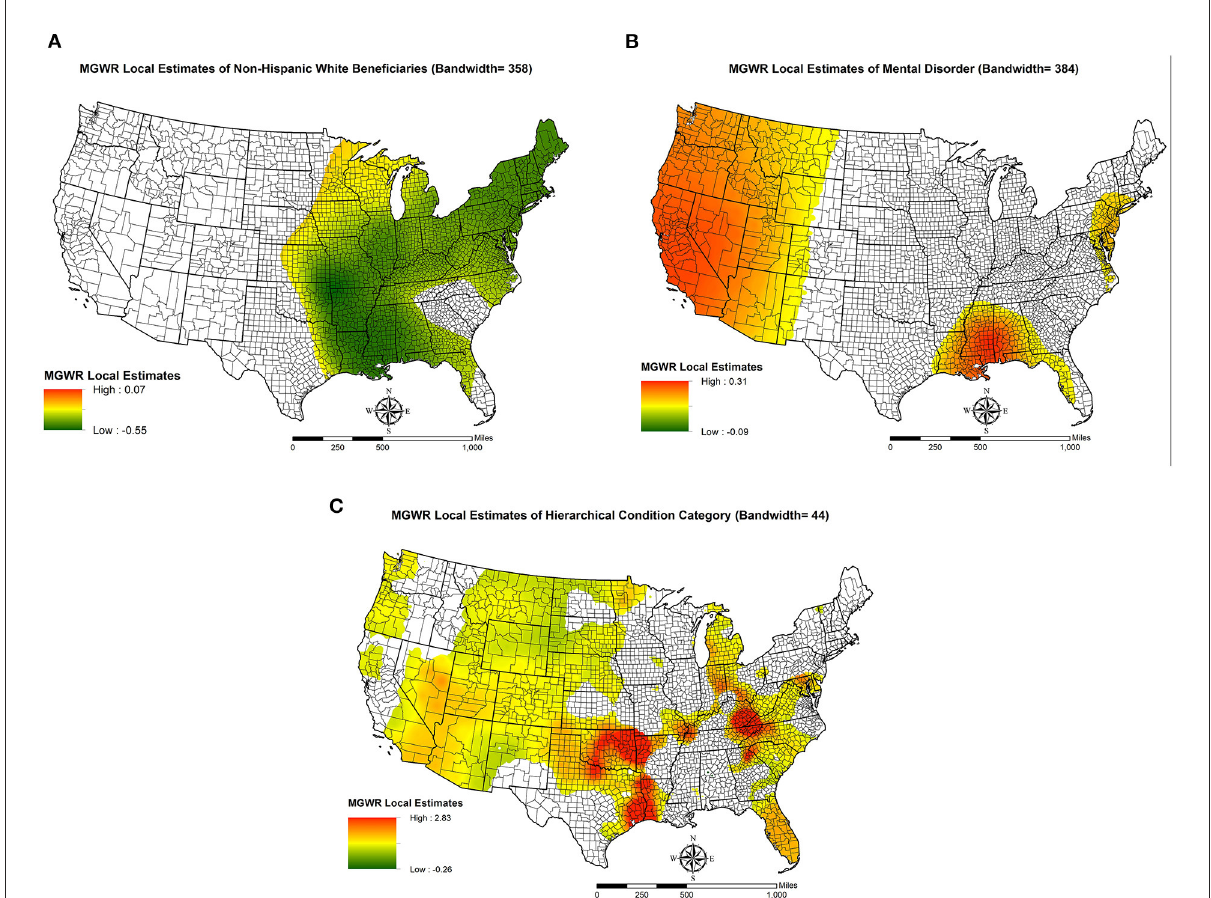
FIGURE2 Spatial non-stationarity in the relationships between key independent variables and opioid use disorder rates (per 1,000 older Medicare beneficiaries) in US counties. (A) MGWR Local Estimates of Non-Hispanic White Beneficiaries (Bandwidth = 358); (B) MGWR Local Estimates of Mental Disorder (Bandwidth = 384); (C) MGWR Local Estimates of Hierarchical Condition Category (Bandwidth =